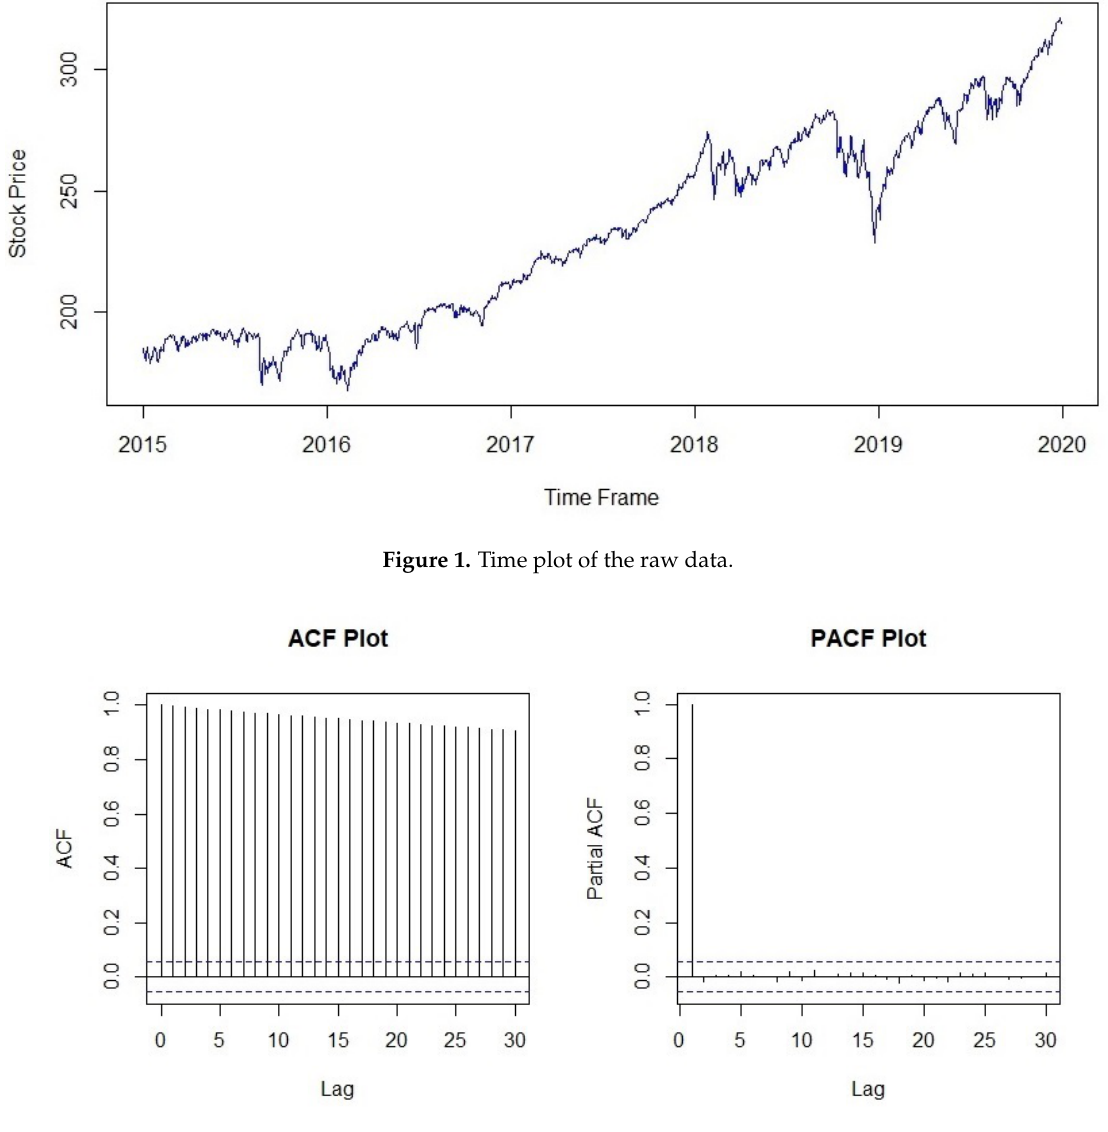
Figure 2. Sample autocorrelation